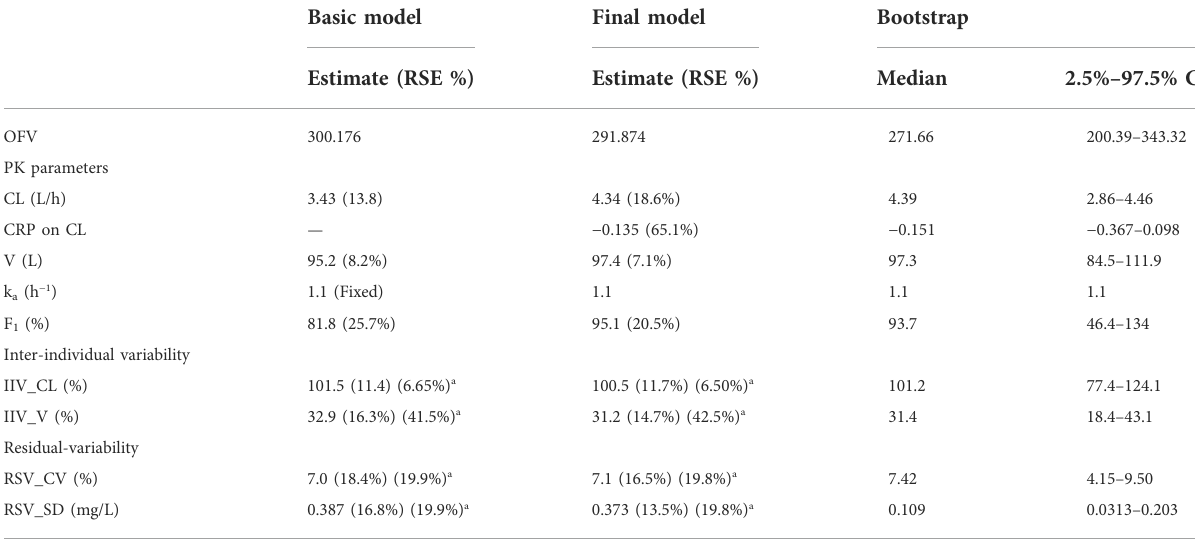
TABLE 2 Parameters estimates of basic, fi nal model and Bootstrap